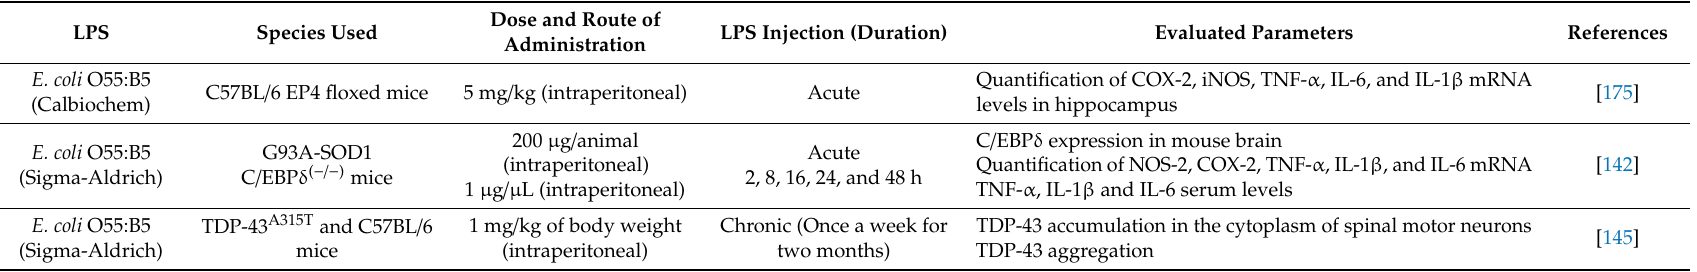
Table 5. LPS source, species used, dose and route of administration, duration, evaluated parameters of models of systemic LPS challenges for the elucidation of amyotrophic lateral sclerosis